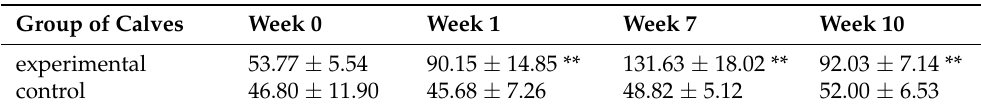
Table 1. Se concentration in serum of calves receiving the novel feed additive in diet ( µ g/L), mean ± SD. Group of